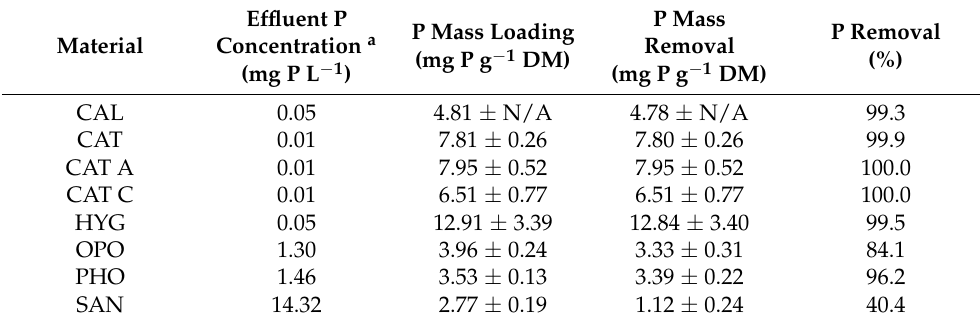
a Last value of running mean, hence, average of the three last measured values ( n = 3). N/A = not